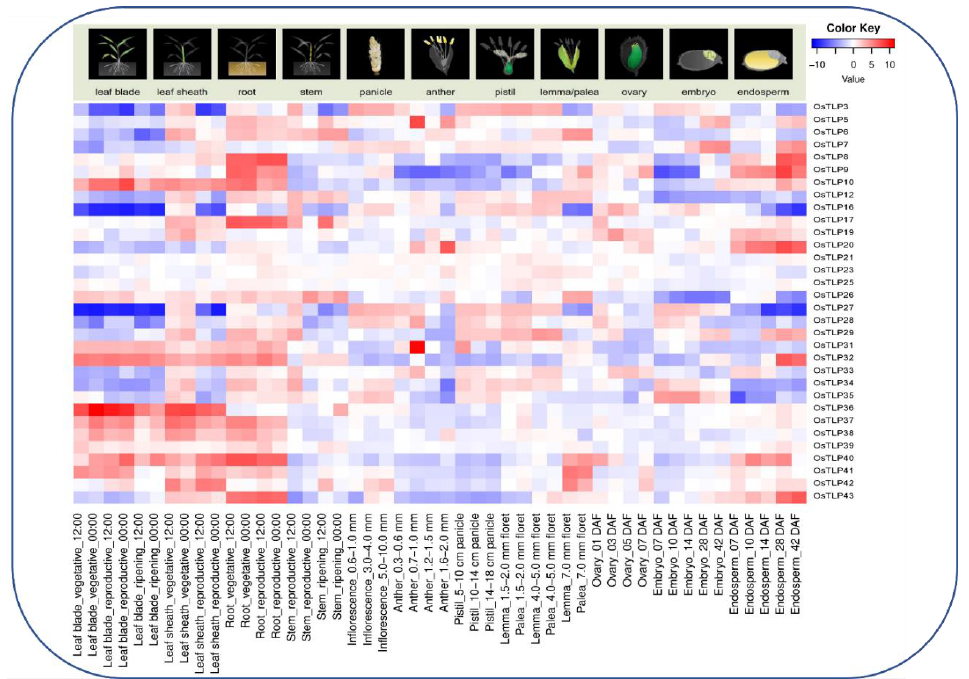
Figure 6. Heatmap of OsTLP genes representation in developmental stages, including leaf blade, leaf sheath, root, stem, inflorescence, pistil, lemma, plea, ovary, embryo, and endosperm. The log2 transformation method normalized and converted the RPKM values